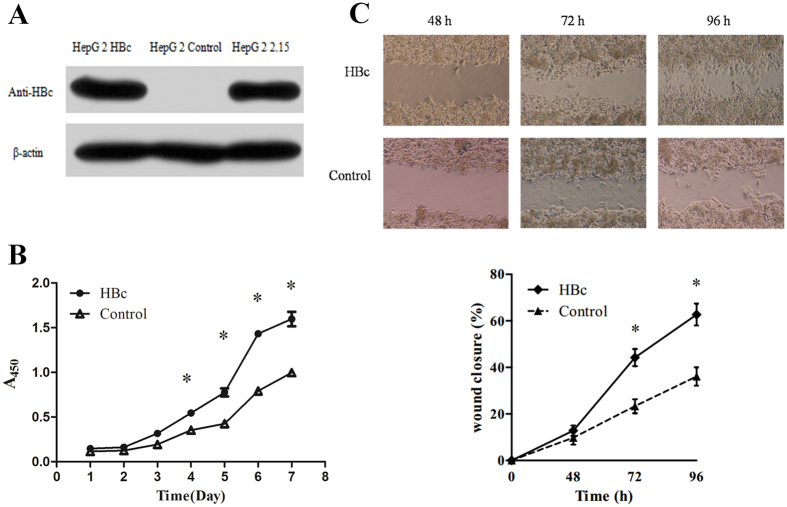
HBc promotes cell proliferation and migration.(A) HBc expression was detected by western blotting. (B) The effect of HBc on cell proliferation was measured using CCK-8 assay (*p < 0.05). (C) The effect of HBc on cell motility was measured using a wound-healing assay. Top: Representative photographs taken at 48 h, 72 h and 96 h post-wound (×100). Bottom: The wound closure was quantified by measuring the remaining unmigrated area using ImageJ.